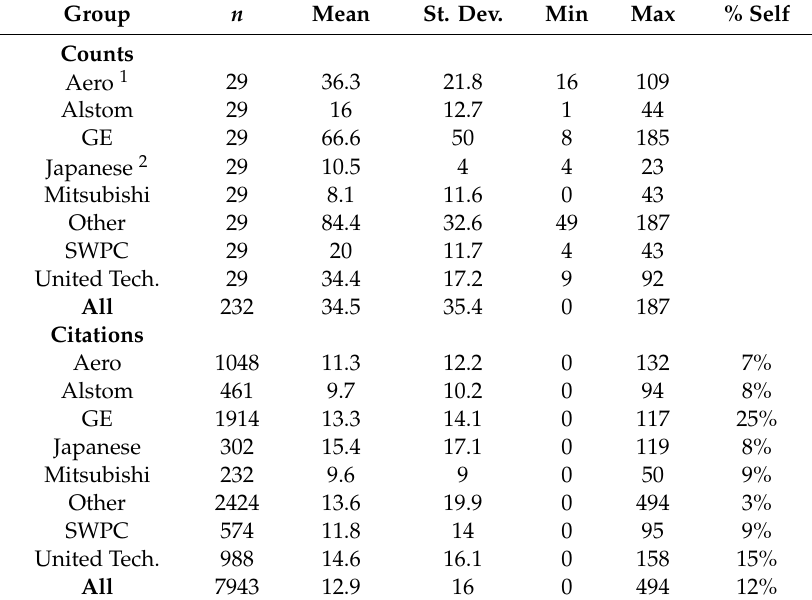
Table 1. Summary statistics for patent groups used in this